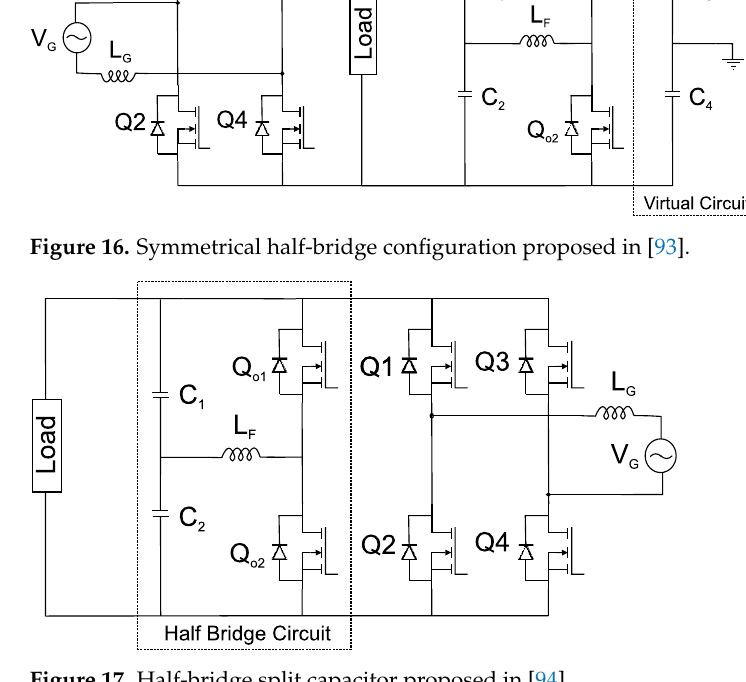
Figure 17. Half-bridge split capacitor proposed in